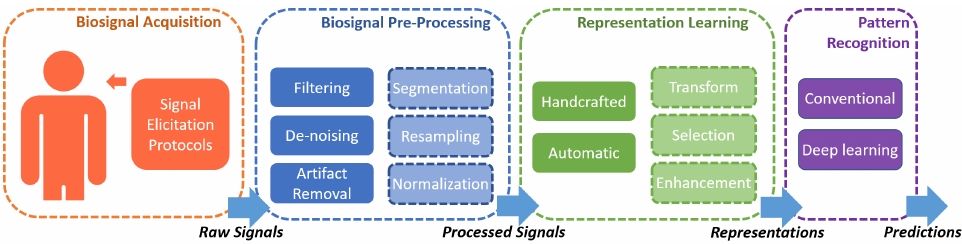
Figure 1. A typical cognitive biometric recognition system